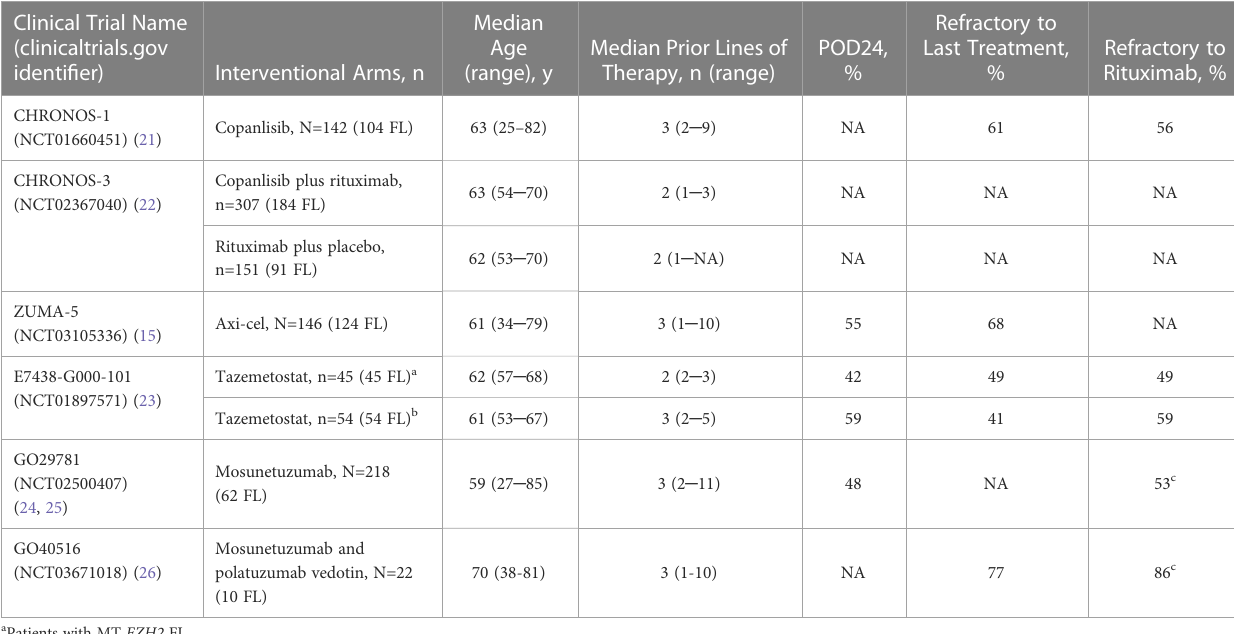
TABLE 1 Patient populations in B-cell lymphoma clinical trials. Clinical Trial